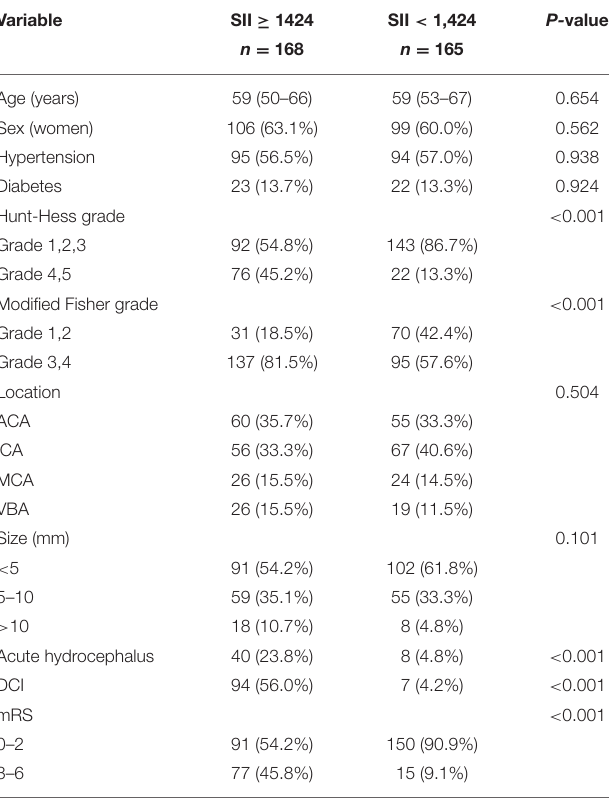
TABLE 4 | Baseline characteristics of included SAH patients dichotomized to the identified SII threshold (1,424). Variable